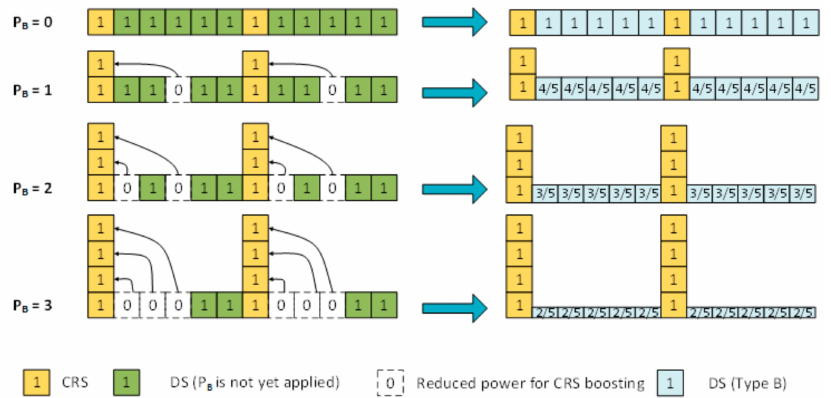
Figure 6. Power boosting for type B orthogonal frequency-division multiplexing (OFDM) symbols.